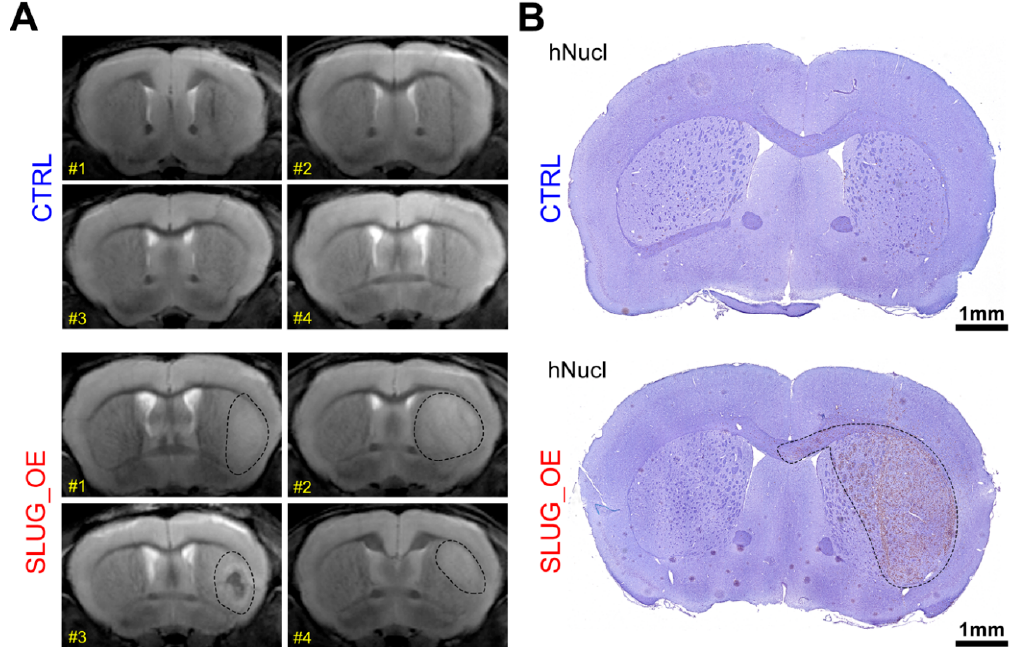
Figure 6. Cont . Figure 6.